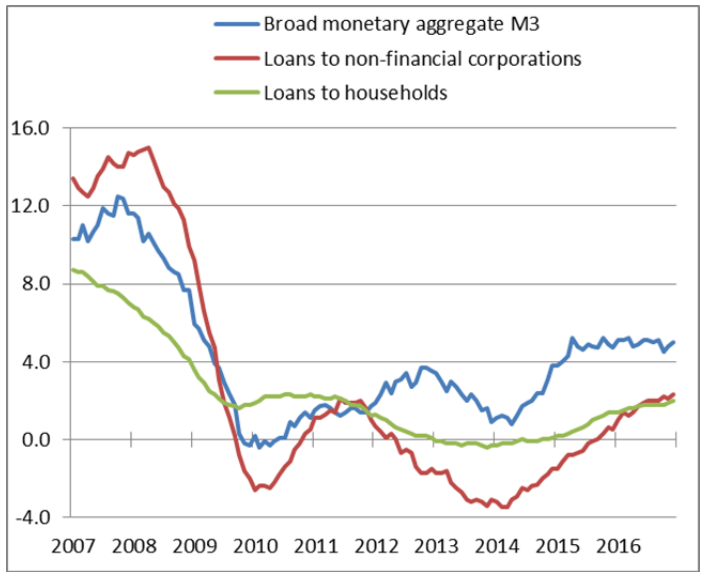
Figure 7. Broad monetary aggregate M3 and bank lending to the non-financial private sector (annual percentage changes). Source: ECB. Latest observation: December 2016. Note: Bank loans are adjusted for loan sales, securitization and notional cash pooling.